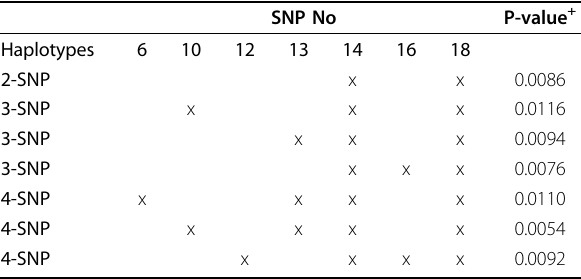
Table 7 MMP - 1 and 12 Risk Haplotypes related to disease GOLD severity III and IV combined